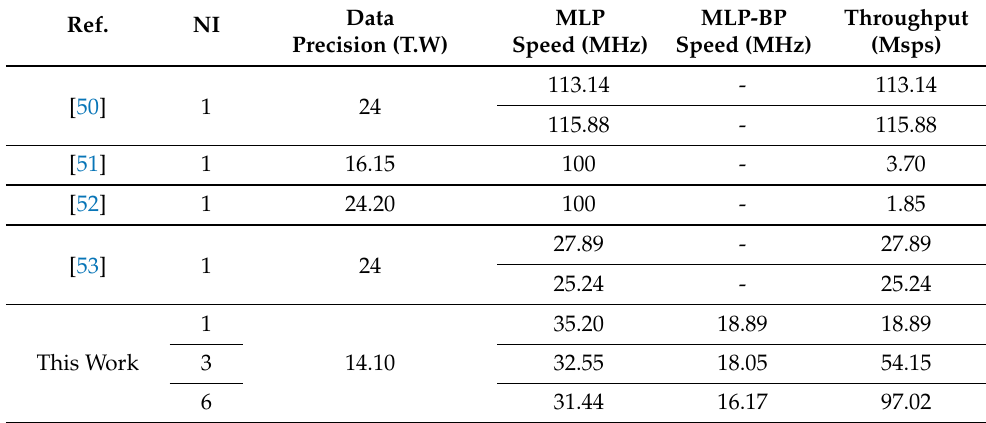
Table 11. Throughput comparison with other state-of-the-art works. Ref.